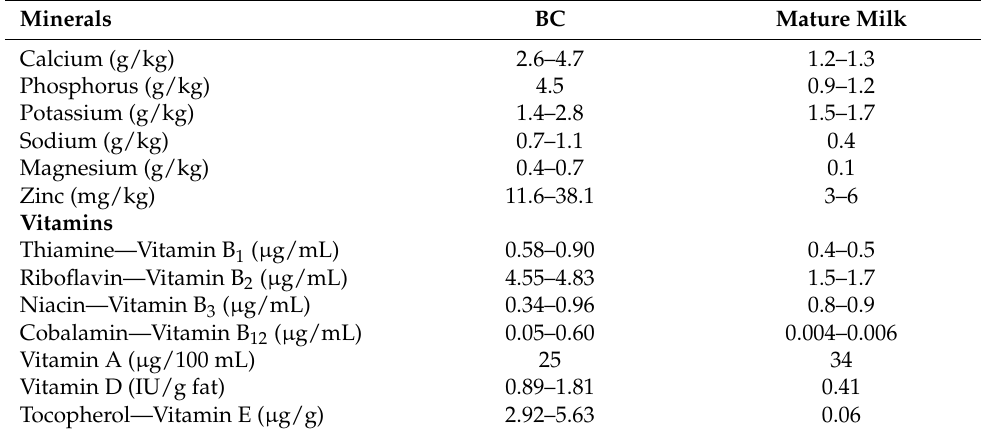
Table 2. Minerals and Vitamins content in BC and in mature milk